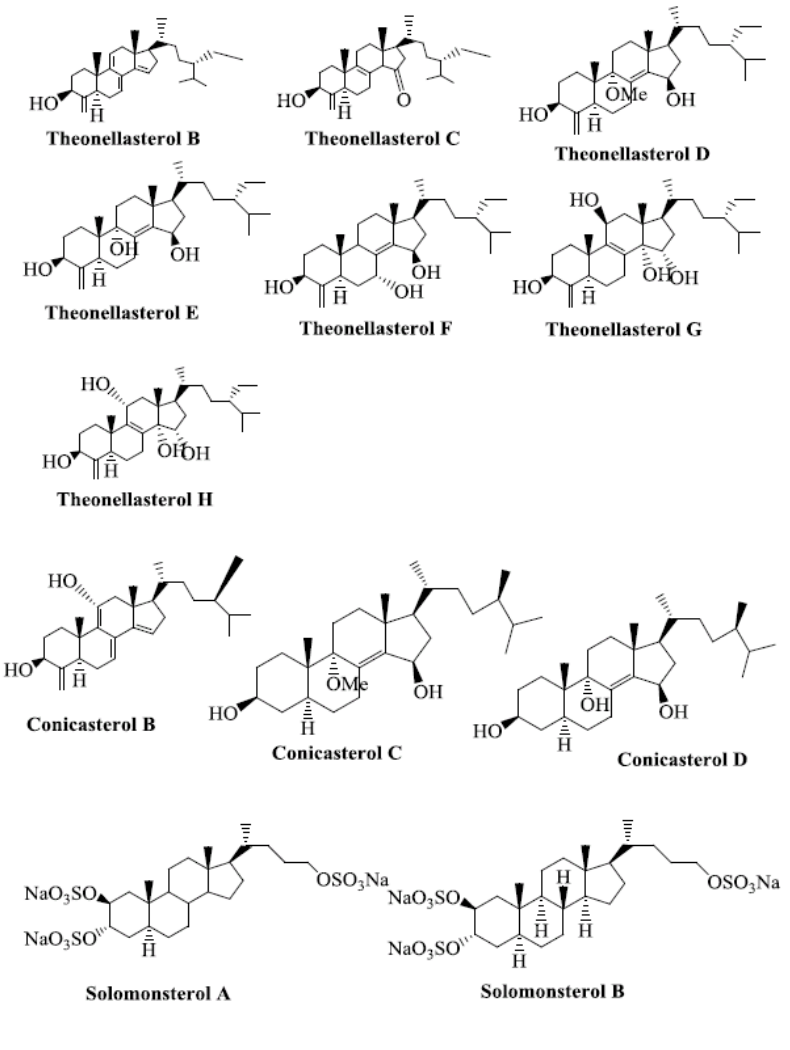
Figure 3. Marine-derived natural steroid ligands reported to activate